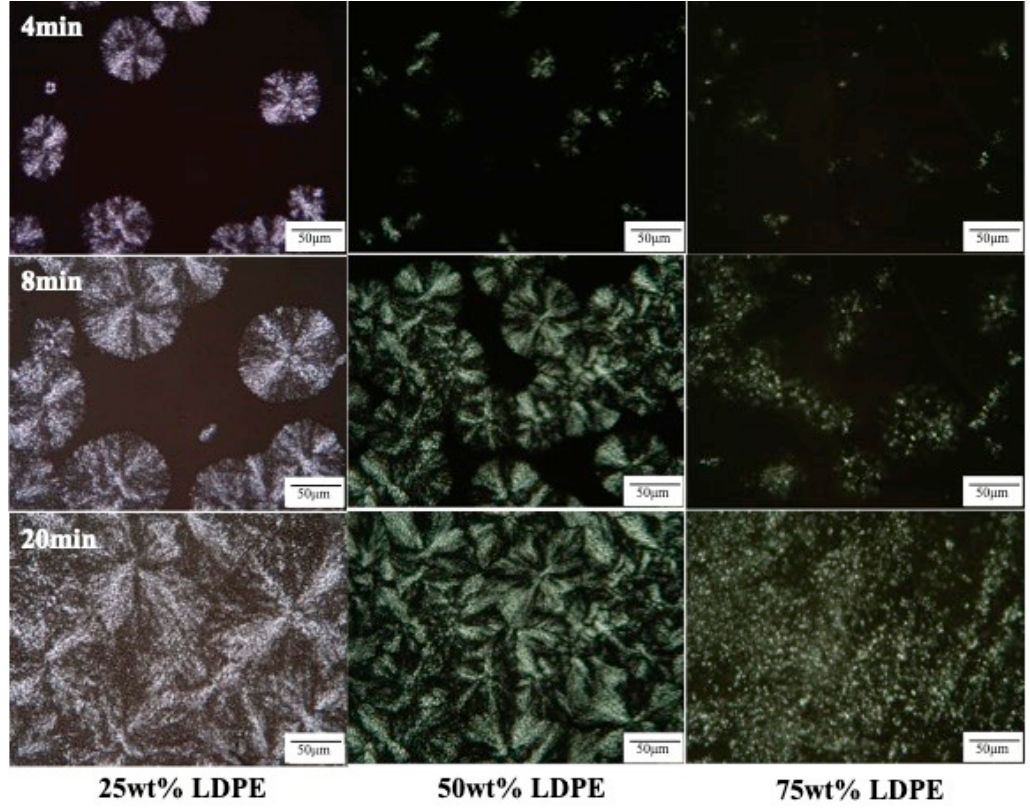
Figure 5. Polarizing optical microscopy of the nucleation and growth process of PP/LDPE blends containing 25 wt % LDPE, 50 wt % LDPE and 75 wt % LDPE during isothermal crystallization at 125 °C.